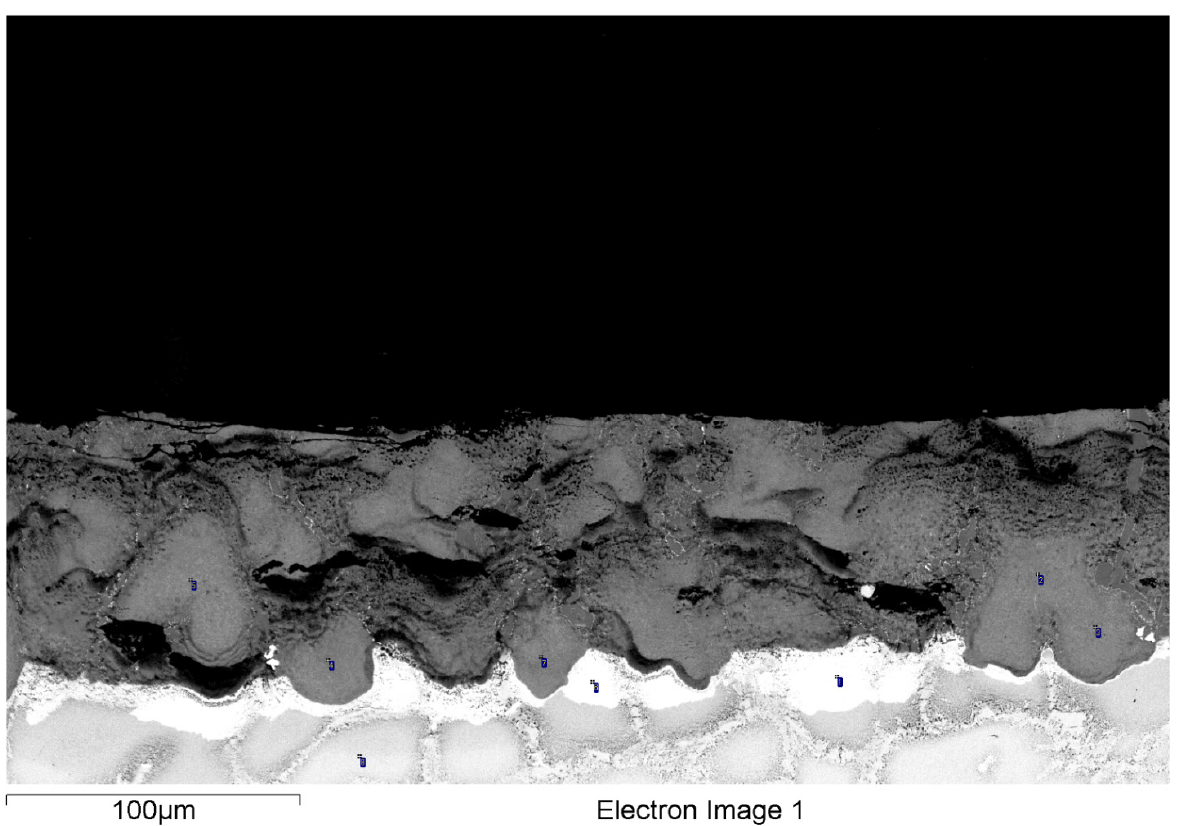
Figure 9. Sn-rich layer formed at the interface between oxide scale and NV1 substrate at 900 °C. Analysis point 1 is on the right-hand side of the bright contrast layer and corresponds to Nb 6 Sn 5 , whereas the analysis point 6 is on the left-hand side of the point 1 and corresponds to Nb 3 Sn. Notice the heavily oxidised areas of Ti-rich Nb ss in the subscale microstruc- ture.